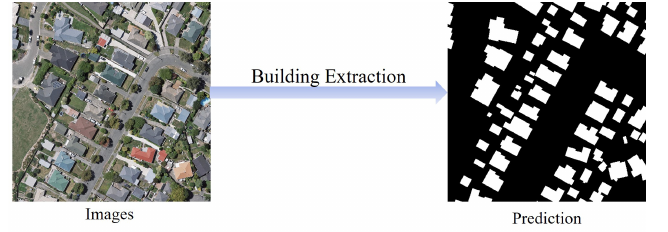
Figure 1. Illustration of extracting buildings from remote sensing images. The white and black pixels in prediction denote buildings and background